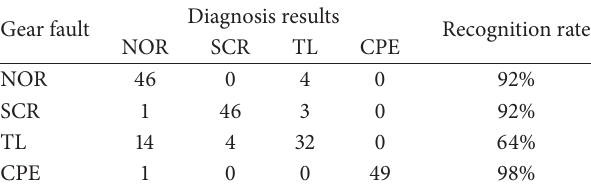
Table 6: Classification results with proposed method (DFA6). Diagnosis results Gear fault